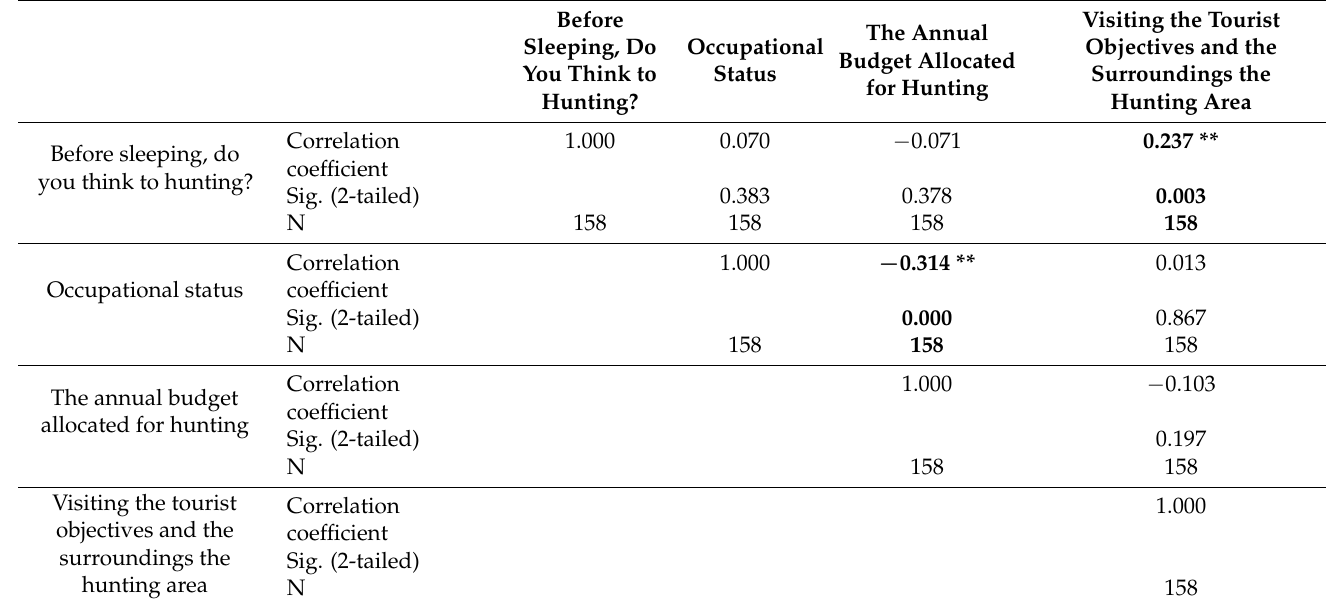
Table 4. Correlation coefficients for